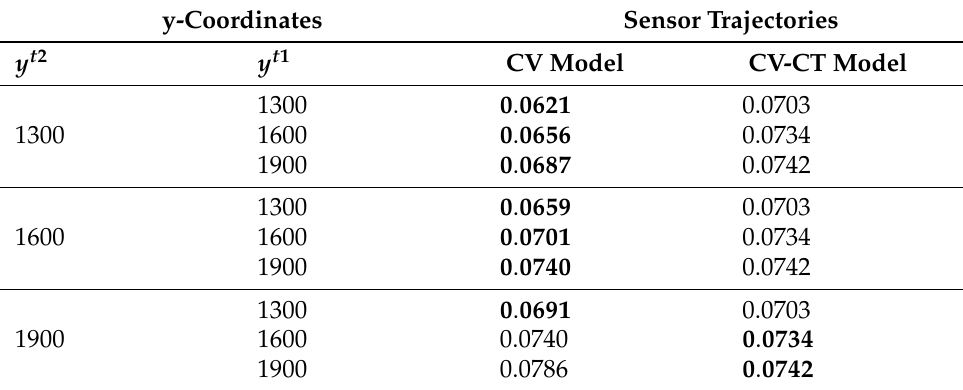
Table 1. PCRLB (in degrees) of γ b (in degrees) with different sensor trajectories and various locations of two targets of